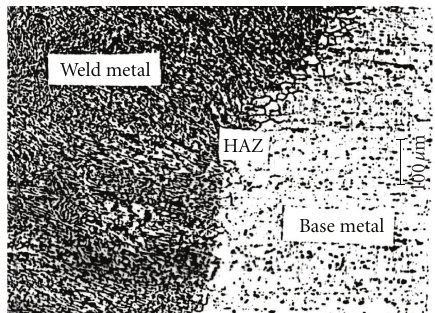
Figure 11: Optical micrograph of fusion boundary of AA6061 butt